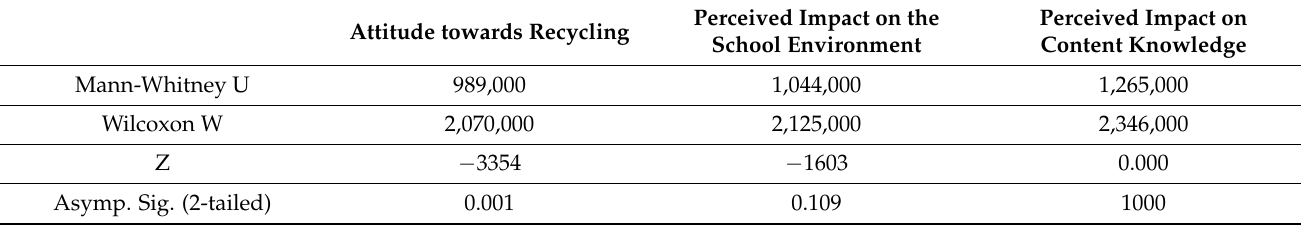
Table 7. A comparison of control group learners’ attitudes towards recycling, perceived impact on content knowledge, and perceived impact on the school environment, measured before and after the school-based recycling